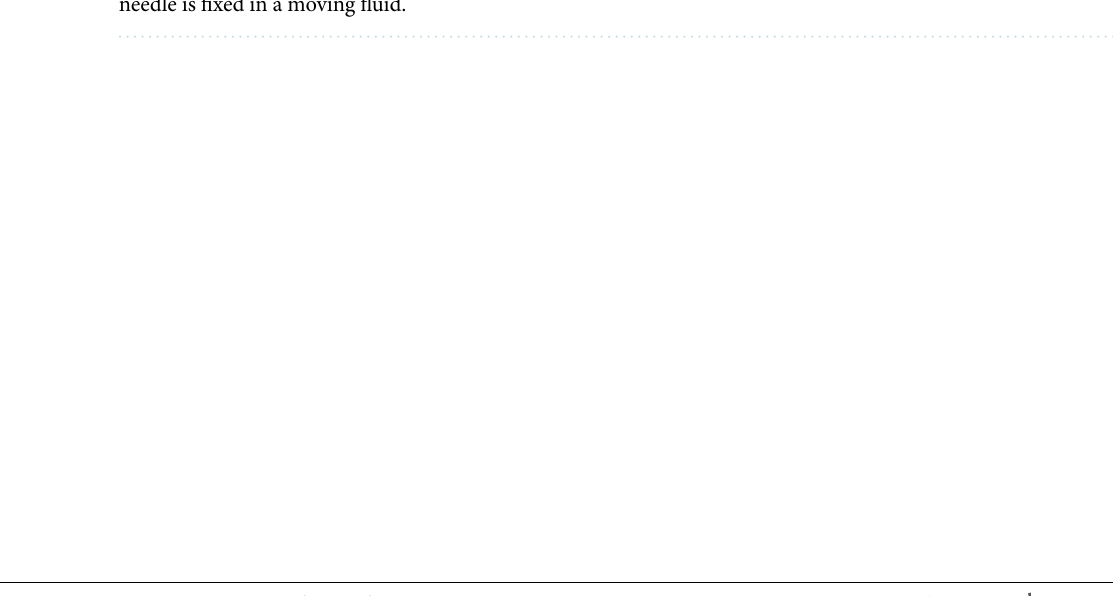
Figure 12. Effects of magnetic and porosity parameters on Bejan number for (a) air and (b) water, when the needle is fixed in a moving